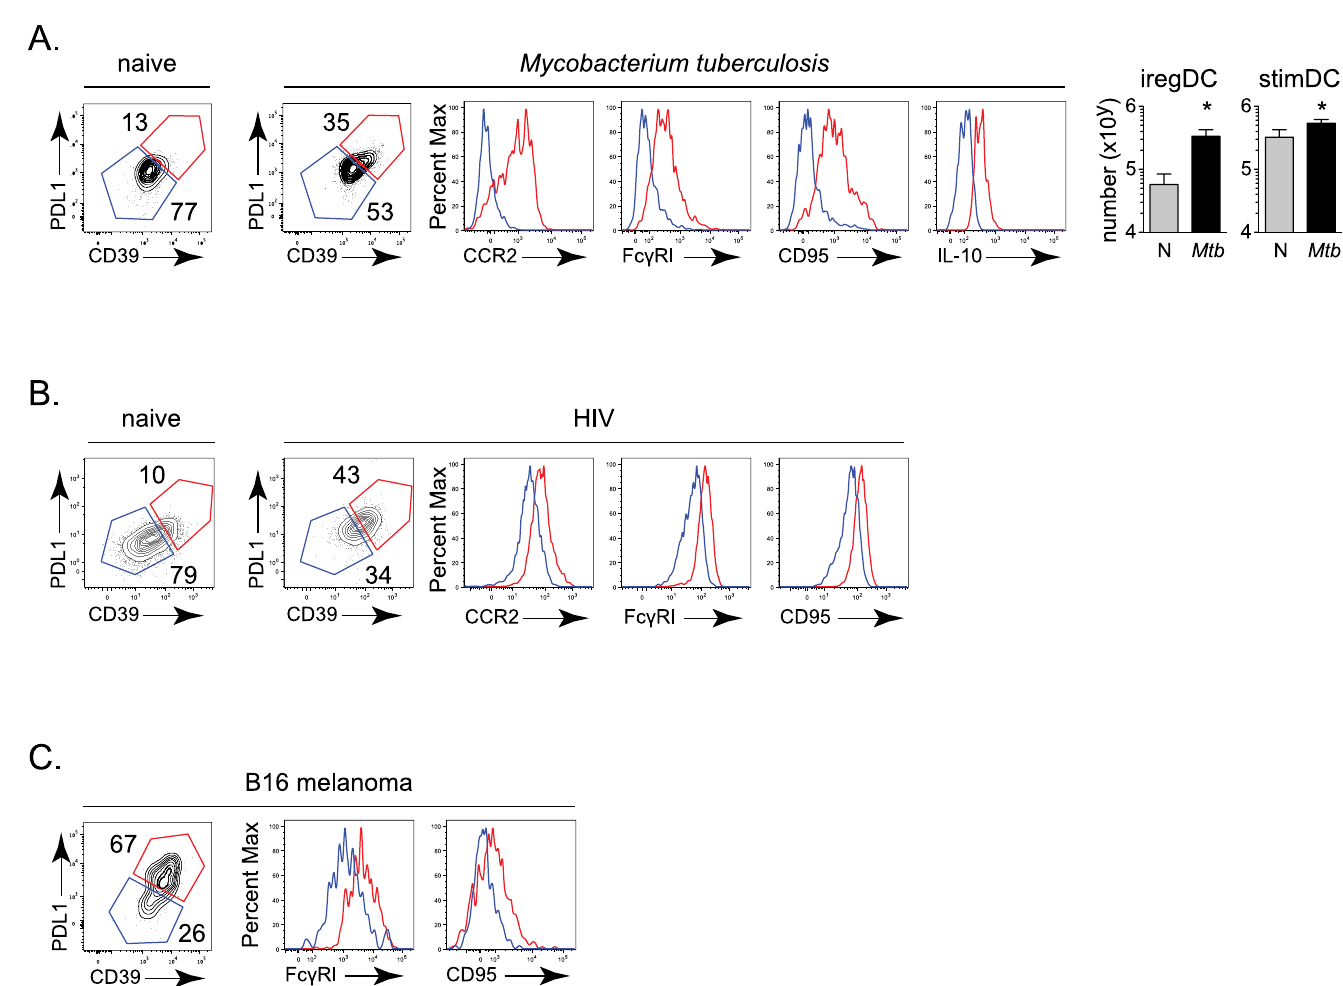
Fig 7. Monocyte-derived iregDCs develop in Mtb infection, HIV infection and cancer. A. Flow plots show CD39 and PDL1 expression on splenic CD11b + DCs from IL-10 reporter mice either uninfected or infected with virulent Mtb for 36 days. Histograms indicate expression of the indicated protein on iregDC (red) and stimDC (blue). Bar graphs indicate the number of iregDC and stimDC in uninfected and Mtb infected mice. B. Flow plots show CD39, PDL1 and monocyte-associated proteins on CD11c++, HLA-DR+, CD14+ iregDC (red) and stimDC (blue) from the peripheral blood of na ï ve humanized mice and HIV infected humanized mice. C. Flow plots show CD39, PDL1 and monocyte-associated proteins on CD11b+, CD11c++ iregDC (red) and stimDC (blue) on B16 melanoma infiltrating leukocytes. Data are representative of 2 or more independent experiments each consisting of 4 – 7 mice per group. * , p <